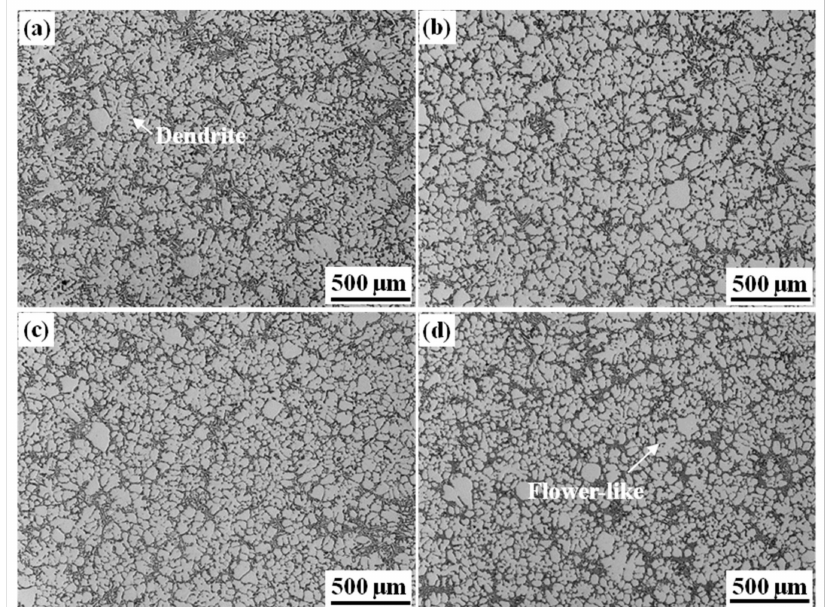
Figure 1. Optical images of alloys with different initial Fe content: ( a ) 0.8%; ( b ) 1.2%; ( c ) 1.8%; ( d ) 2.4%.